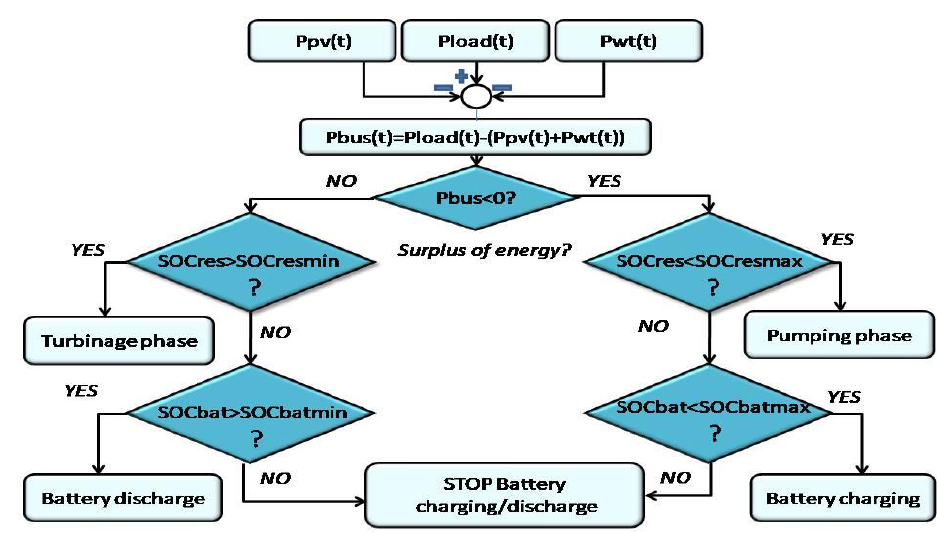
Figure 2. Flowchart of the hybrid PV/wind hydraulic/battery multi storage system operation.